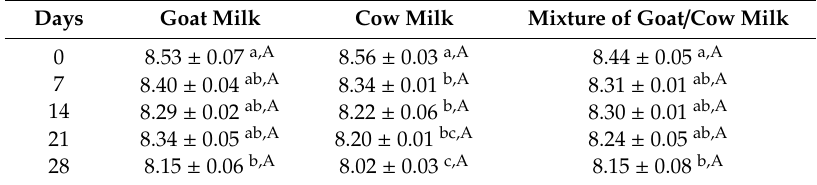
Table 3. Survival (log CFU g − 1 ) of Streptococcus thermophilus in fermented milk during refrigerated storage at 4 ◦ C.